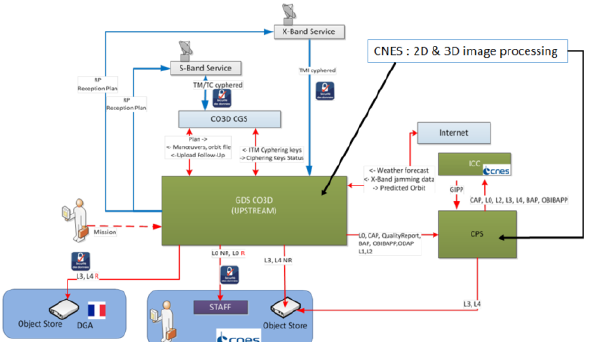
Figure 5. CO3D Ground Segment